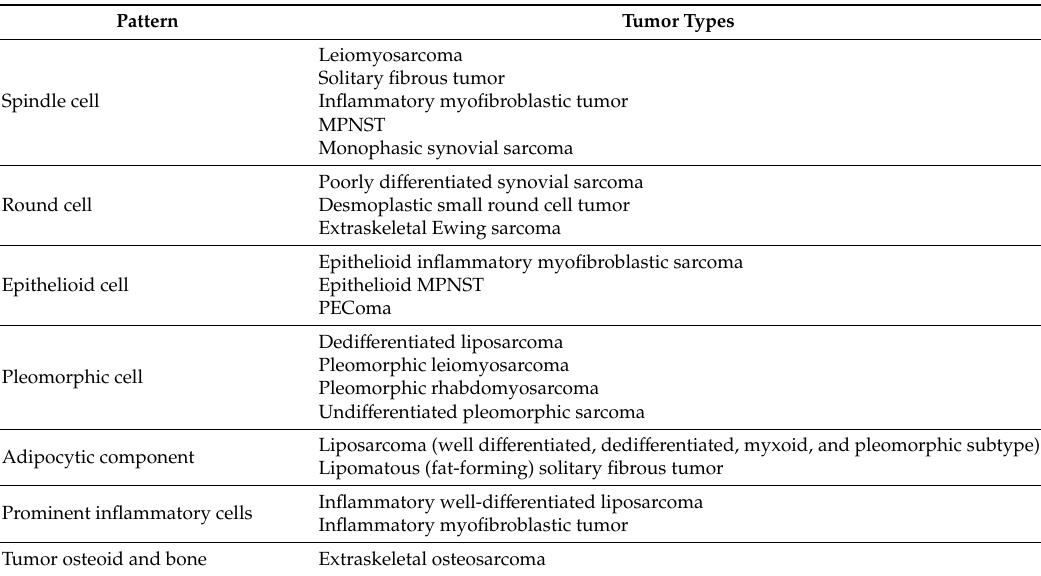
Table 2. Pattern and additional findings of retroperitoneal mesenchymal